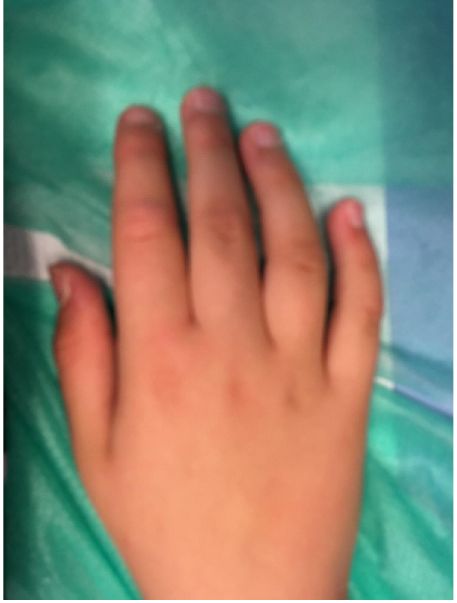
Figure 3: Small and short hands in girl with Cohen syndrome.